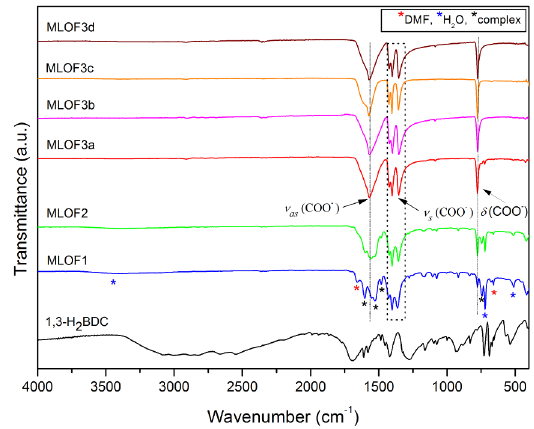
Figure 3. FTIR spectra of the prepared MLOF samples compared to the pure 1,3 - H 2